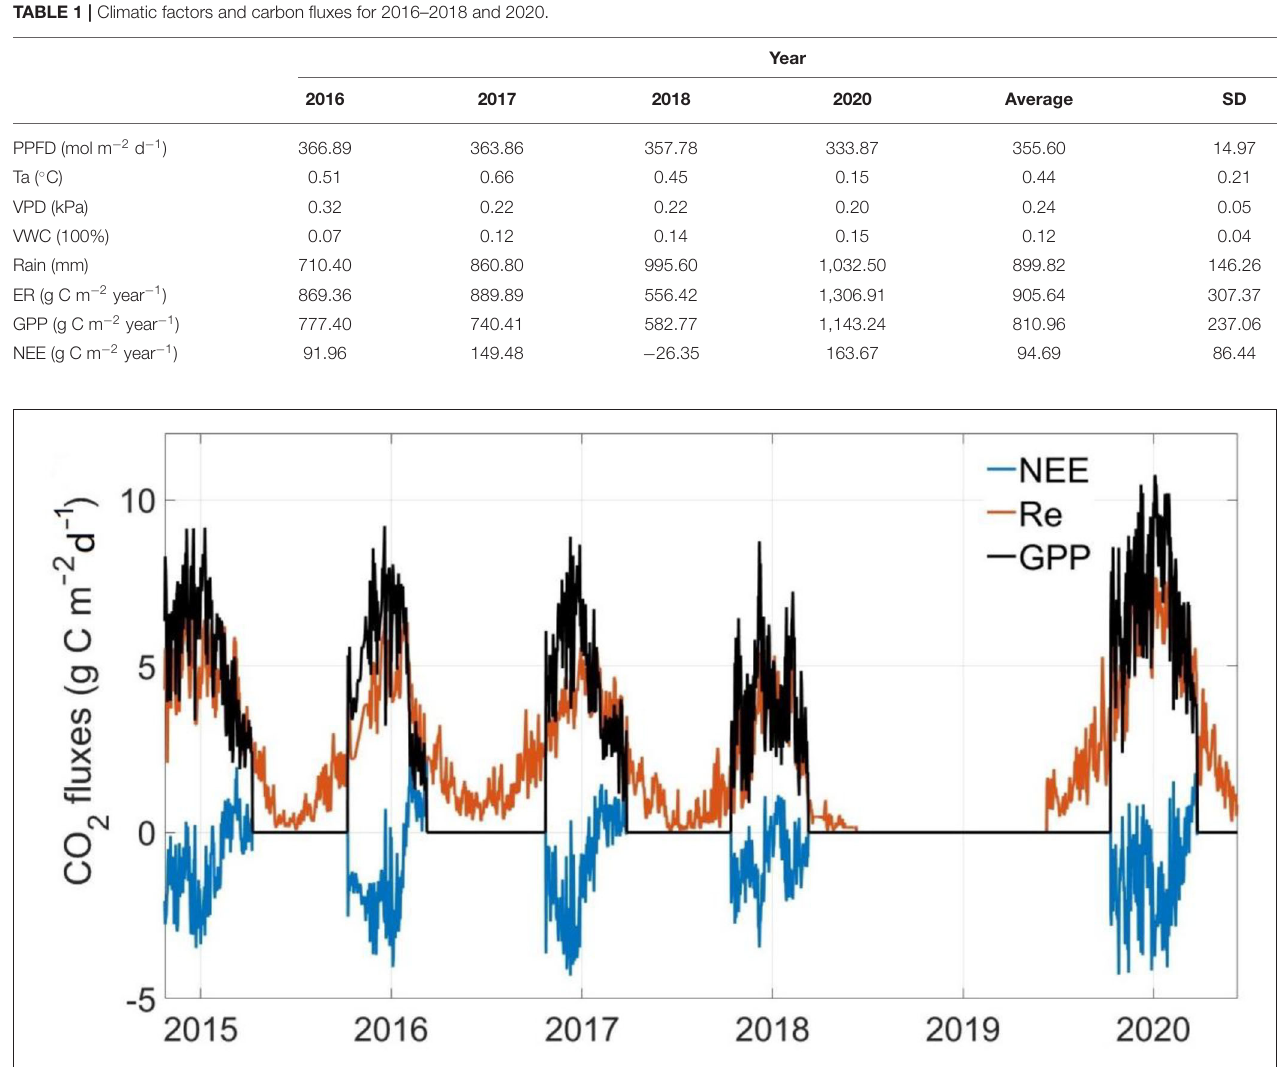
FIGURE 4 | Seasonal and inter-annual variation in the daily average net ecosystem CO 2 exchange (NEE), gross primary productivity (GPP), and ecosystem respiration (Re).